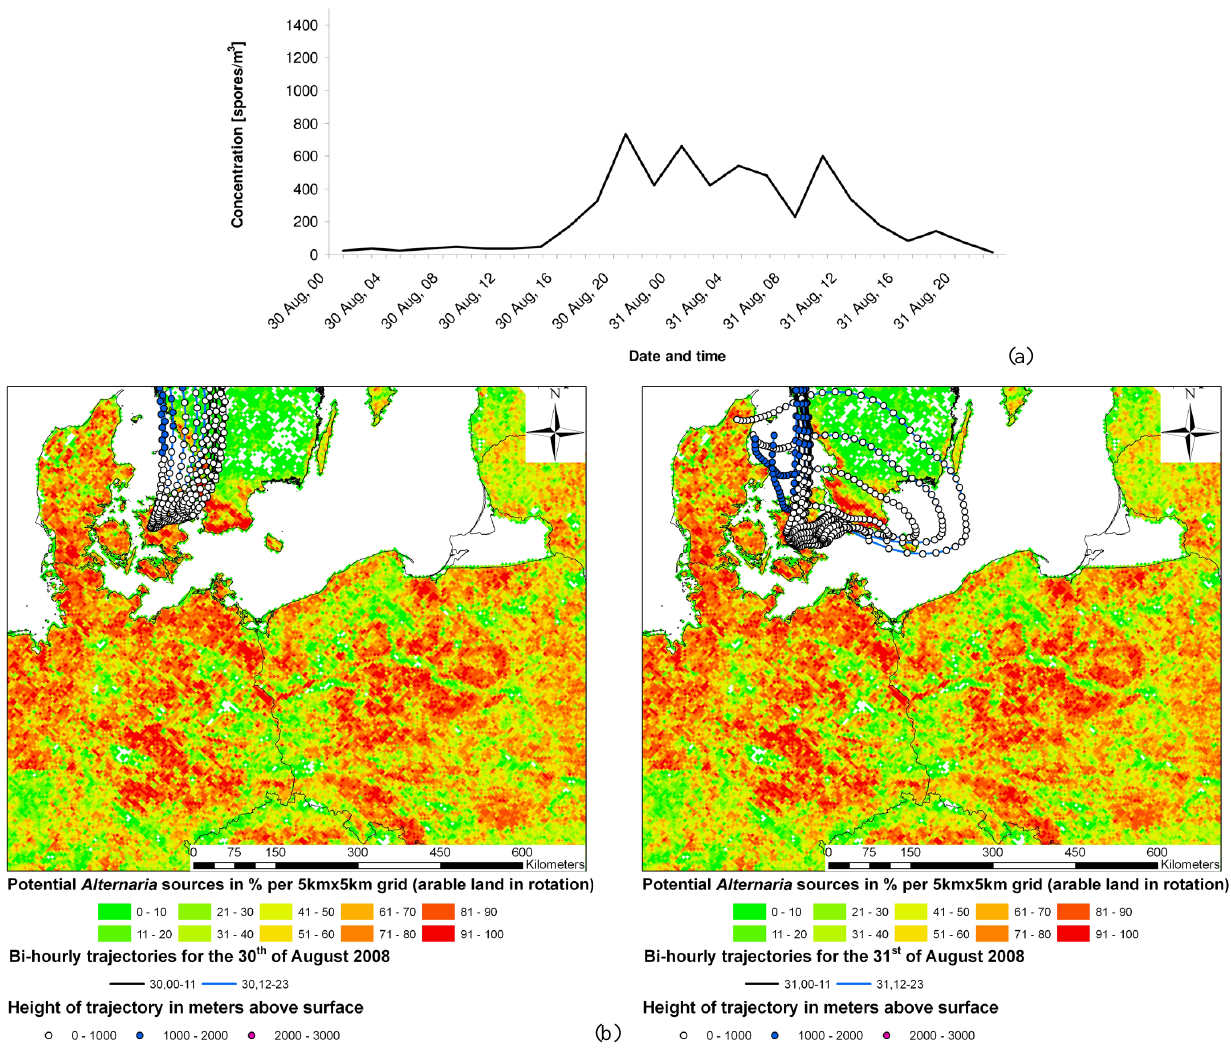
Fig. 3. (a) Bi-hourly variation in Alternaria spore concentrations (sporesm − 3 ) obtained in Copenhagen 30 and 31 August 2008. Back- trajectories arriving at the spore trap in Copenhagen: (b) 30 August; (c) 31 August. The distance between two dots on a trajectory corresponds to one hour of atmospheric